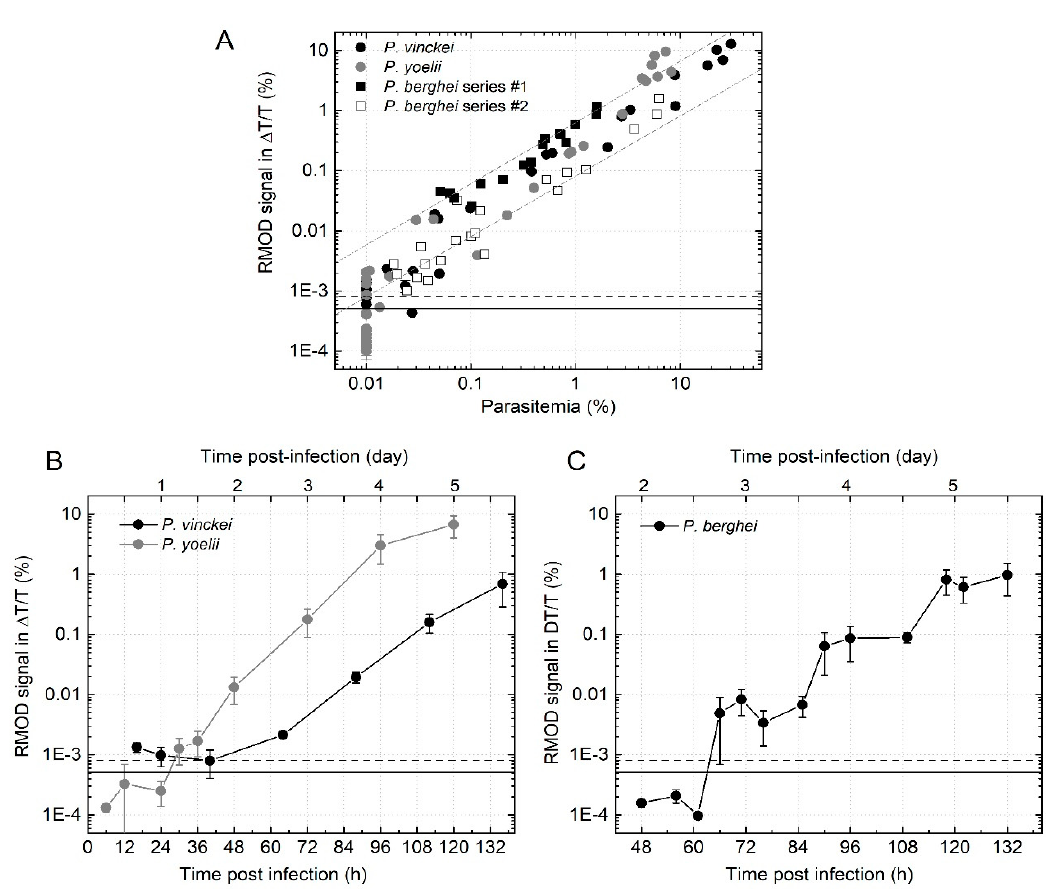
Figure 1. Analysis of the relationship of parasitemia and rotating-crystal magneto-optical diagnostic (RMOD) signal and the hemozoin production rates of three rodent Plasmodium species. ( A ) The RMOD signals plotted as a function of parasitemia. Each point shows a measurement on one mouse of a given series in a given time point. Black and gray circles represent Plasmodium vinckei and P. yoelii infections, and empty and filled black squares display two independent P. berghei infection experiments, respectively. Data on P. berghei are reproduced for the purpose of comparison from reference [4]. ( B ) The progression of the blood-stage infections of P. vinckei and P. yoelii parasites in vivo, monitored by the hemozoin production over time. Each circle and error bar represents the average and standard deviation of values measured on blood samples from n = 3 and n = 4 mice for the P. vinckei and P. yoelii series, respectively. ( C ) The progression of the blood-stage infections monitored by the hemozoin production of P. berghei parasites in vivo. Each circle and error bar represents the average and standard deviation of values measured on blood samples from n = 4 mice. (reproduced from reference [4]). In all graphs the continuous black line represents the average of the RMOD values of ~20 uninfected control samples. The dashed black lines indicate the detection limit of the RMOD method defined as the average plus two times the standard deviation of the uninfected values. The parasitemia values were determined either by microscopy or by flow cytometry.